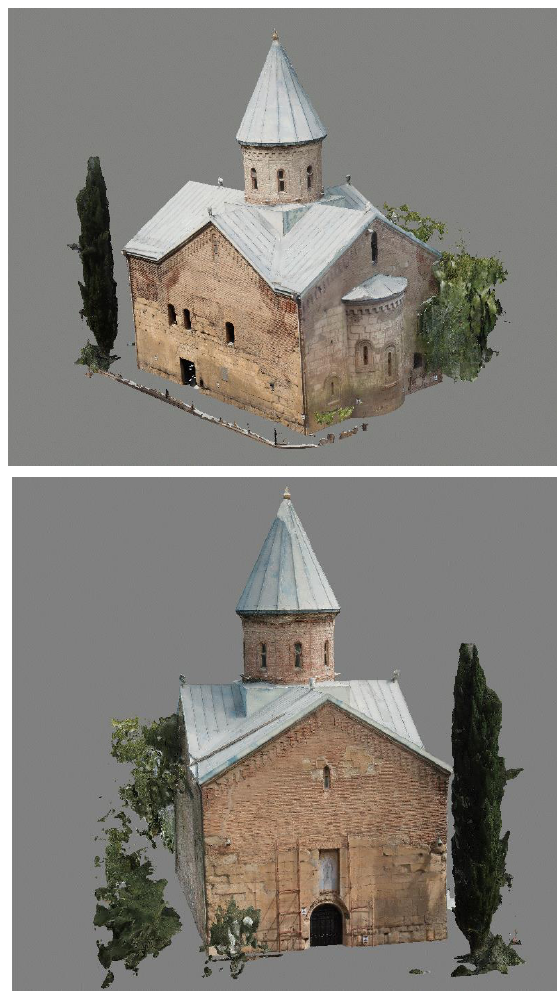
Figure 11. Textured and meshed 3D model from PhotoScan (Alignment "medium", Dense cloud "high", Mesh "arbitrary, high", Texture "adaptive orthophoto, mosaic")